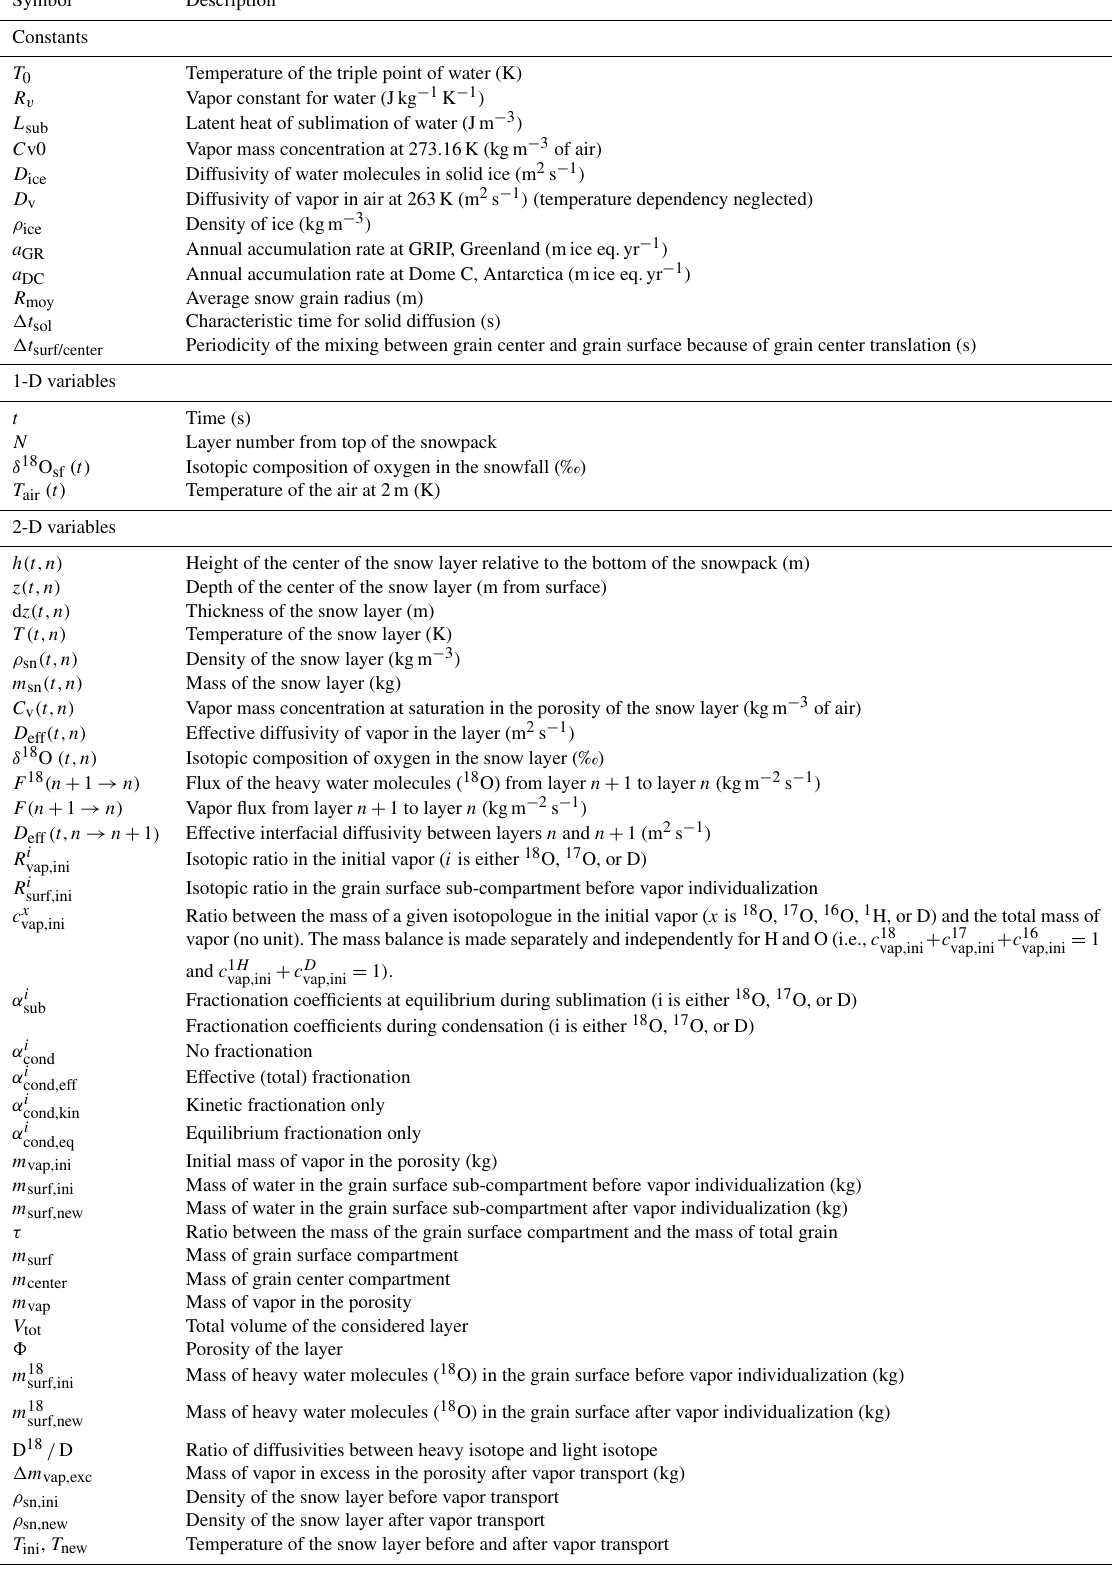
Table 1. Definition of the symbols used.